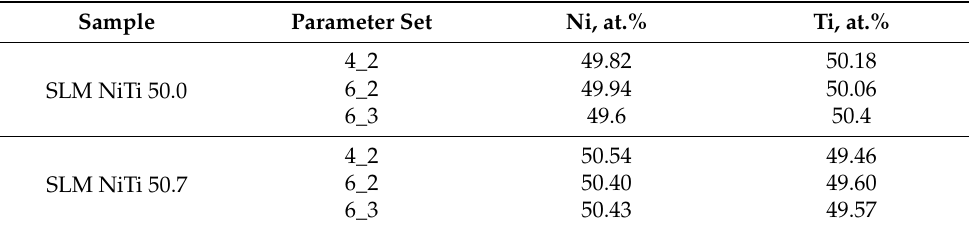
Table 7. The results of the study of the chemical composition of the alloy samples NiTi 50.0 and NiTi 50.7, obtained by the SLM method in a different modes.